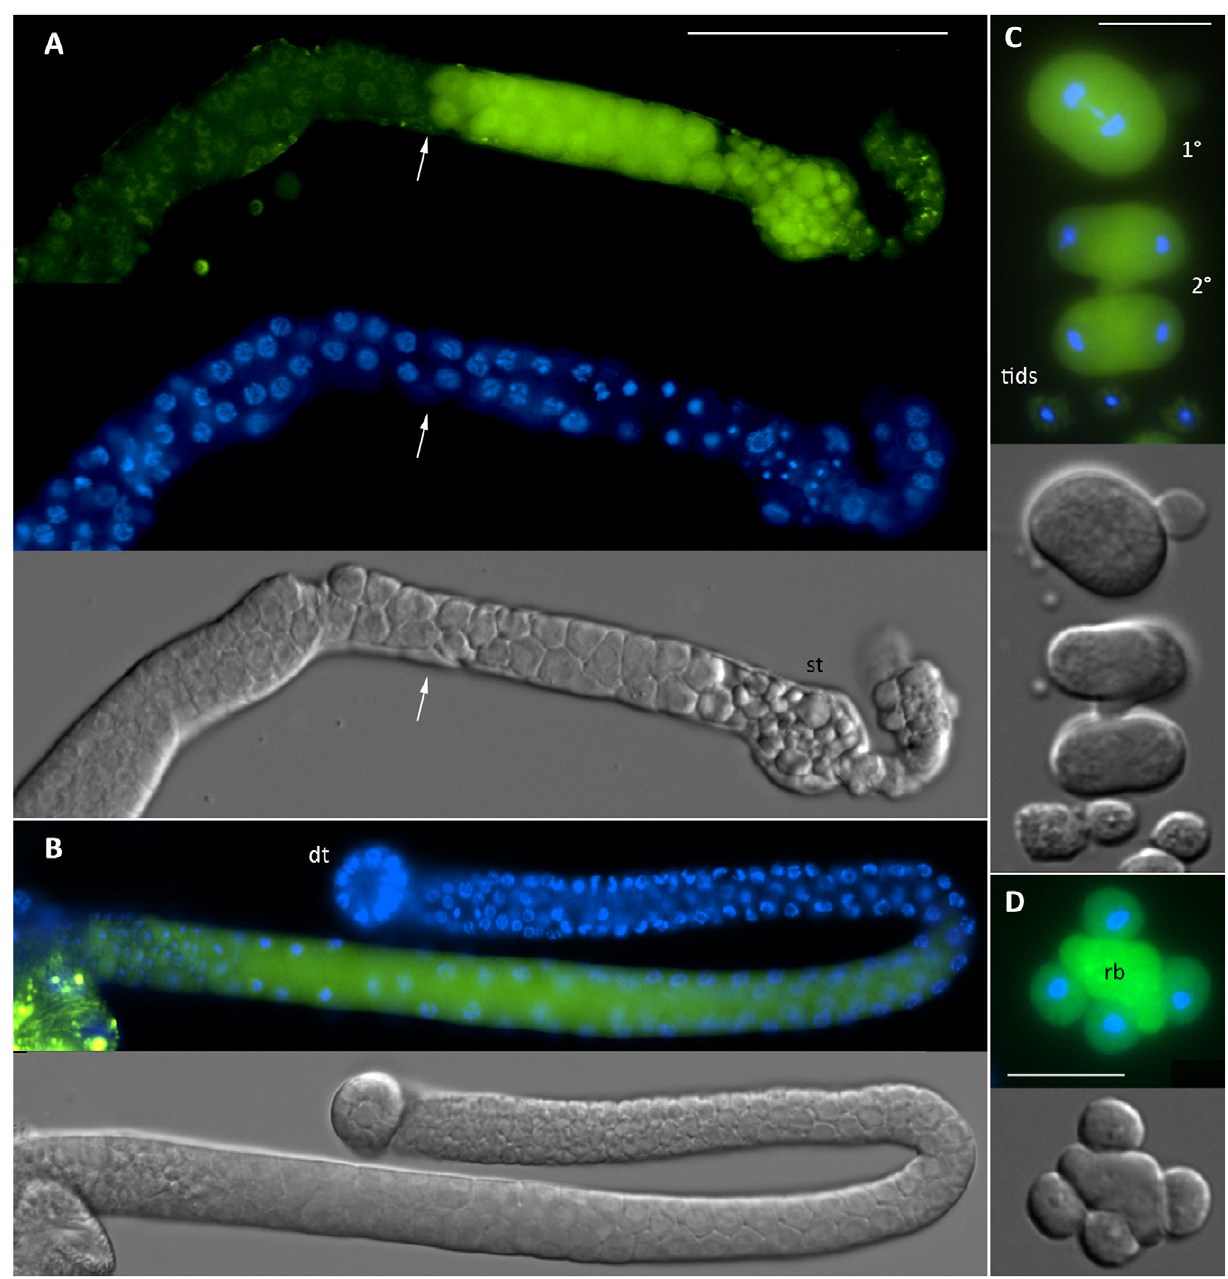
Figure 6. Expression of the spe-46:GFP reporter. Here, the worms expressed an integrated GFP flanked by the spe-46 promoter and 3 9 UTR, and the tissue was labeled with the DNA dye Hoechst 33342. (A) Fluorescence was found in a specific set of cells in the gonads of L4 hermaphrodites, likely those that will produce sperm. The arrow provides reference for the region where GFP expression begins. Gamete maturation proceeds to the right, with the sperm taking up residence in the spermatheca (st). (B) In male gonads, GFP expression corresponds with the transition zone and entry into meiotic pachytene (approximately at the bend in the gonad). dt refers to the distal tip of the gonad. (C) The primary (1 u ) and secondary (2 u ) spermatocytes, and spermatids (tids) are shown. (D) The GFP was detected in the residual body (rb) during the second meiotic division. The scale bar in A is 50 m m and is the same reference for B. The bars in C and D represent 10 m m. doi:10.1371/journal.pone.0057266.g006 assembly of the FB-MO complex. Mutations in both genes affect FB-MO function [27] [29], and the SPE-4 protein is located in the MO membrane [27]. Recently, spe-44 has been identified as a master transcriptional regulator of a large subset of sperm- expressed genes, but it does not directly regulate expression of spe-